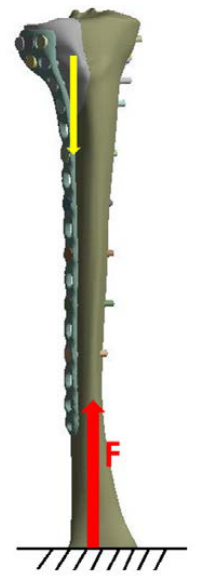
Figure 9 . Scheme of the reaction force F.